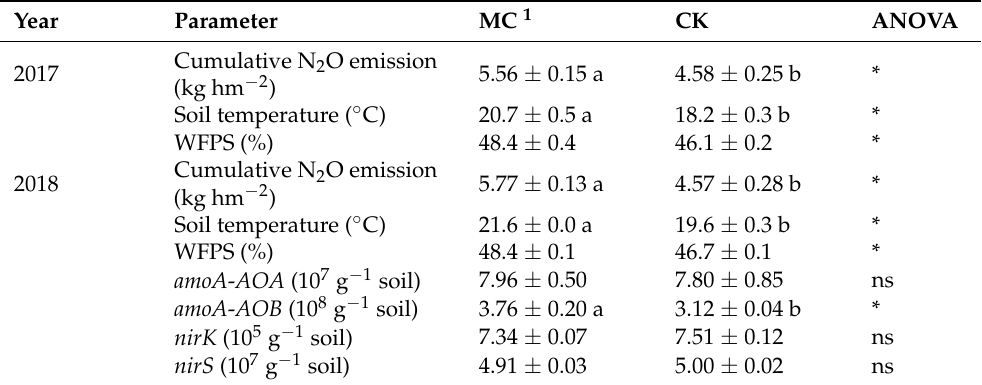
Figure 4. Soil N 2 Orelated gene abundances at the end of the experiment in 2018. Different letters above each bar indicate a significant difference between black plastic film mulching (MC) and non-mulched (CK) treatment at p < 0.05. Table 1. Cumulative N 2 O emissions, soil temperatures, WFPS, and soil N 2 O-related gene abundances as affected by black plastic film mulching treatment.